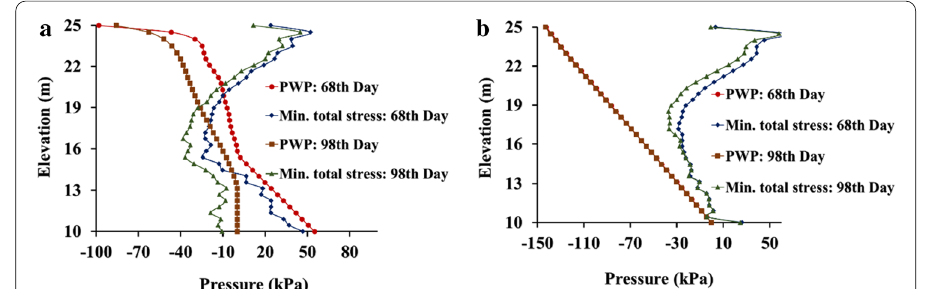
Fig. 25 Comparison of total minor principal stress with the developed PWP to identify the possible location of hydraulic fracturing pertaining to reservoir drawdown operation initiated before the steady-state phreatic surface is attained a upstream face, b downstream face